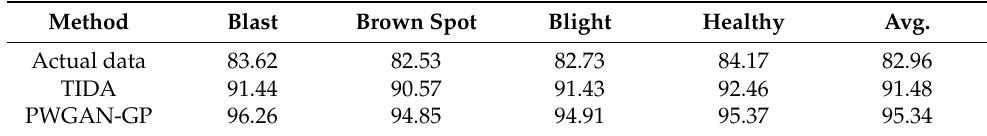
Table 11. Impact of data enhancement on the accuracy of the GoogLeNet model (%).